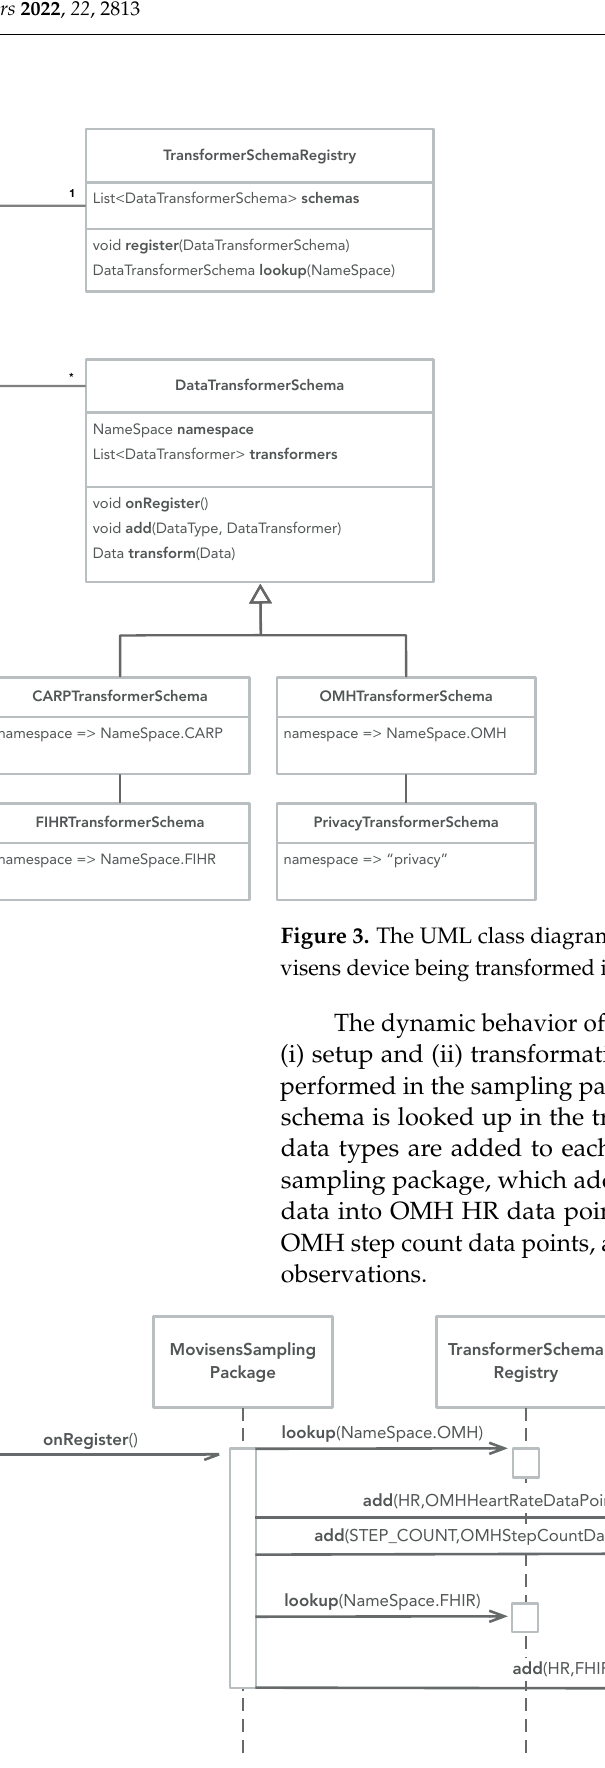
Figure 4. The UML interaction diagram of the setup phase of the data transformation